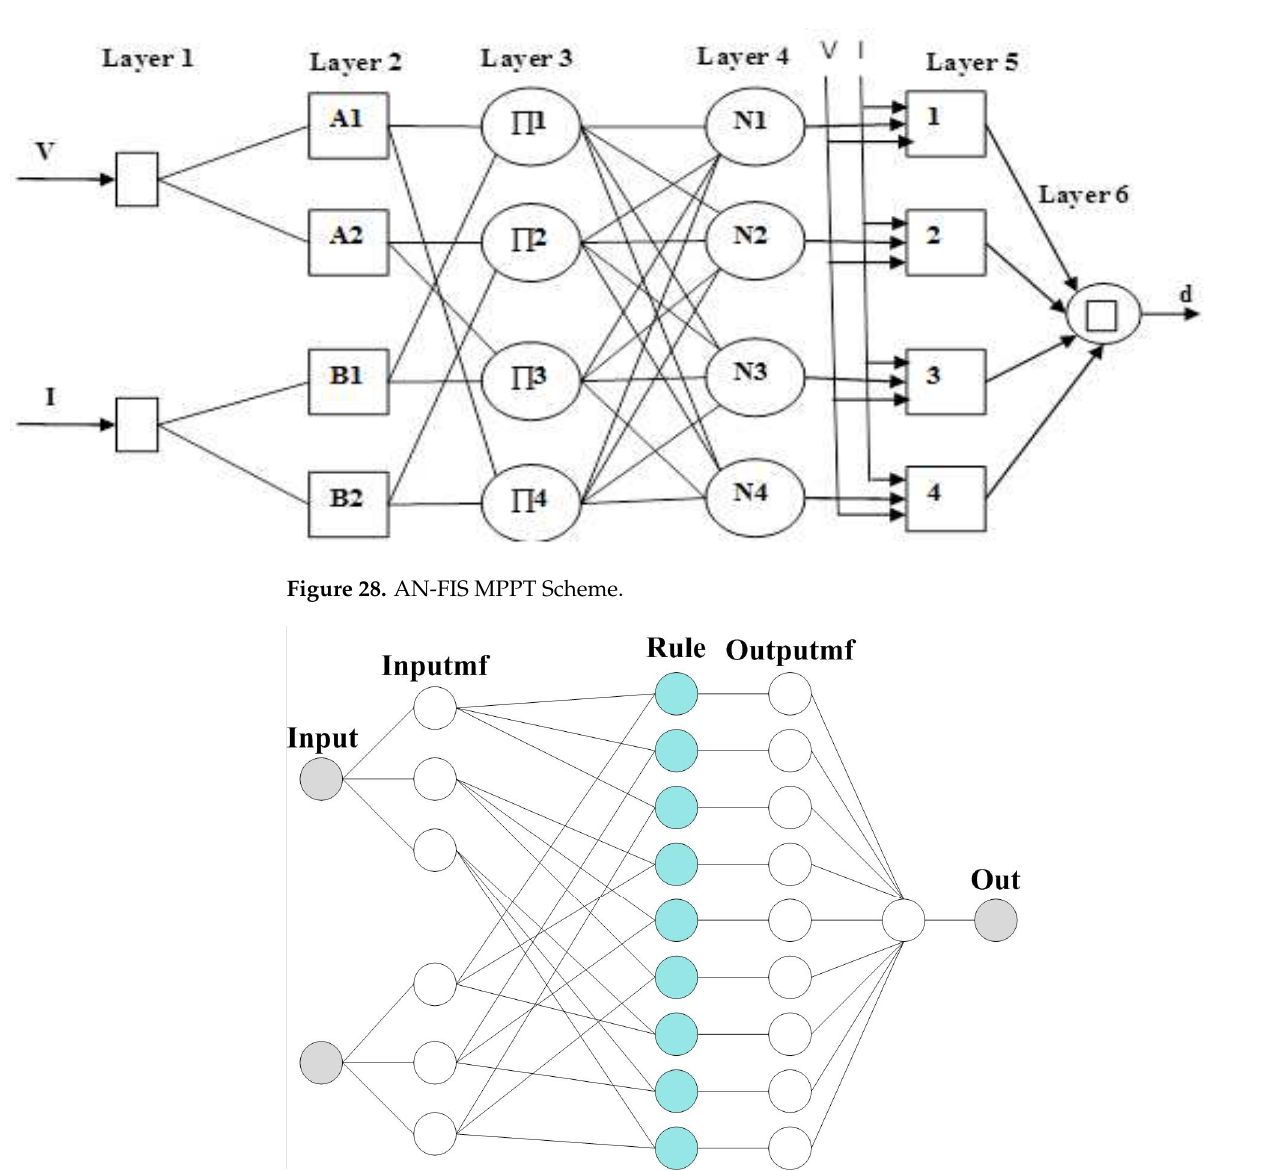
Figure 29. AN-FIS Model configuration.